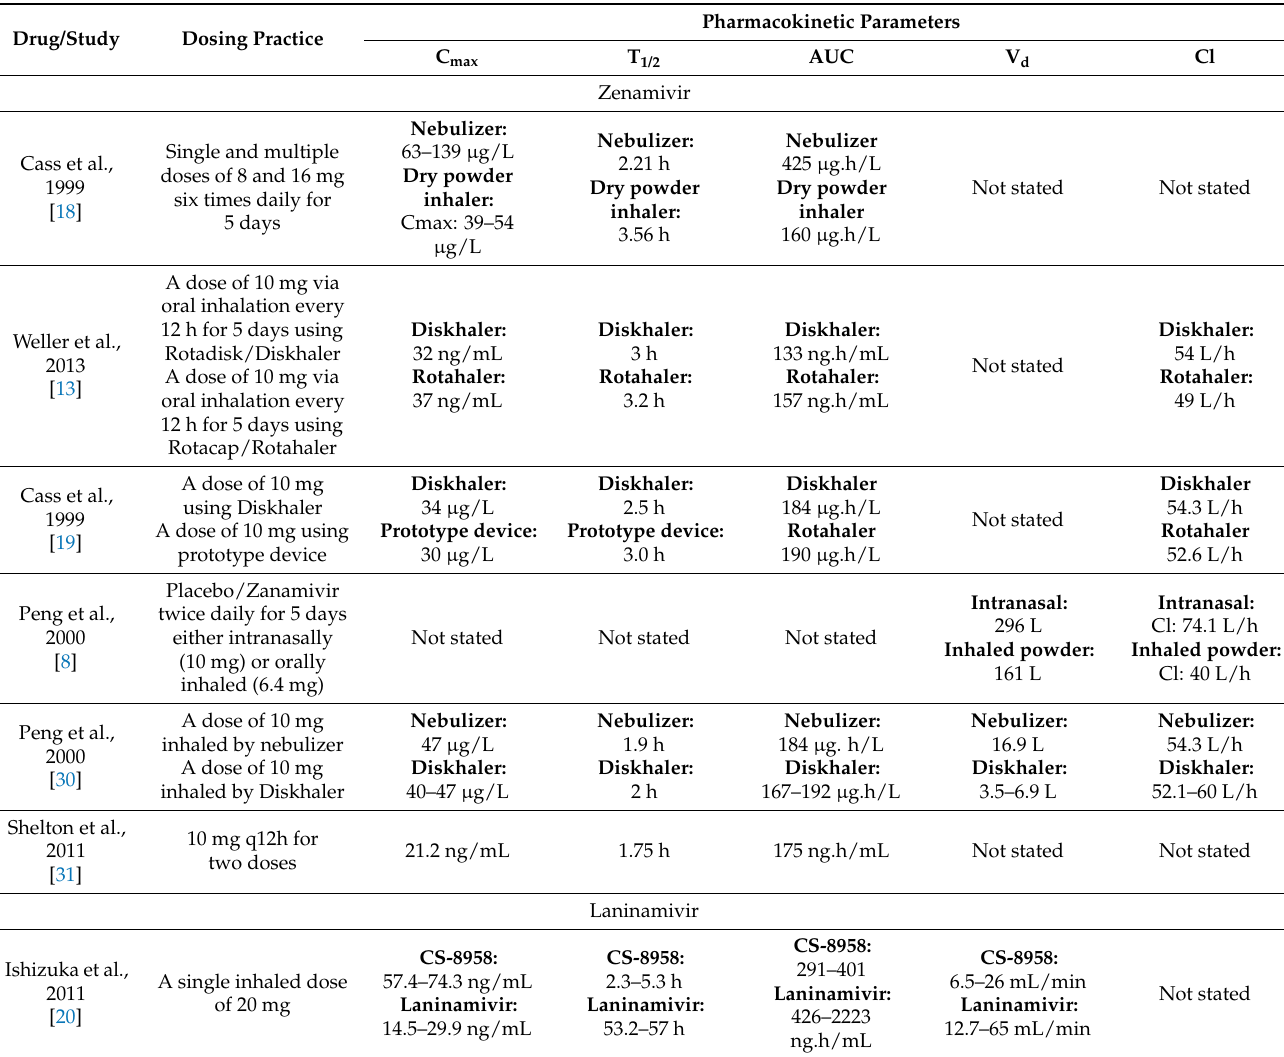
Table 3. Pharmacokinetic parameters of inhaled antiviral